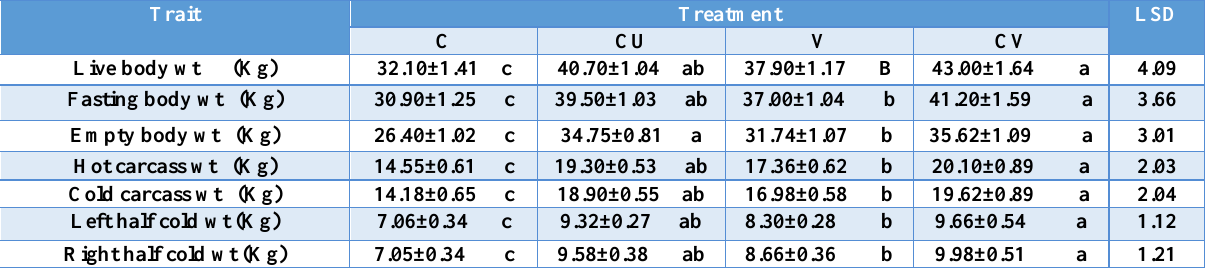
Different letters showed significant difference among treatments at 5%